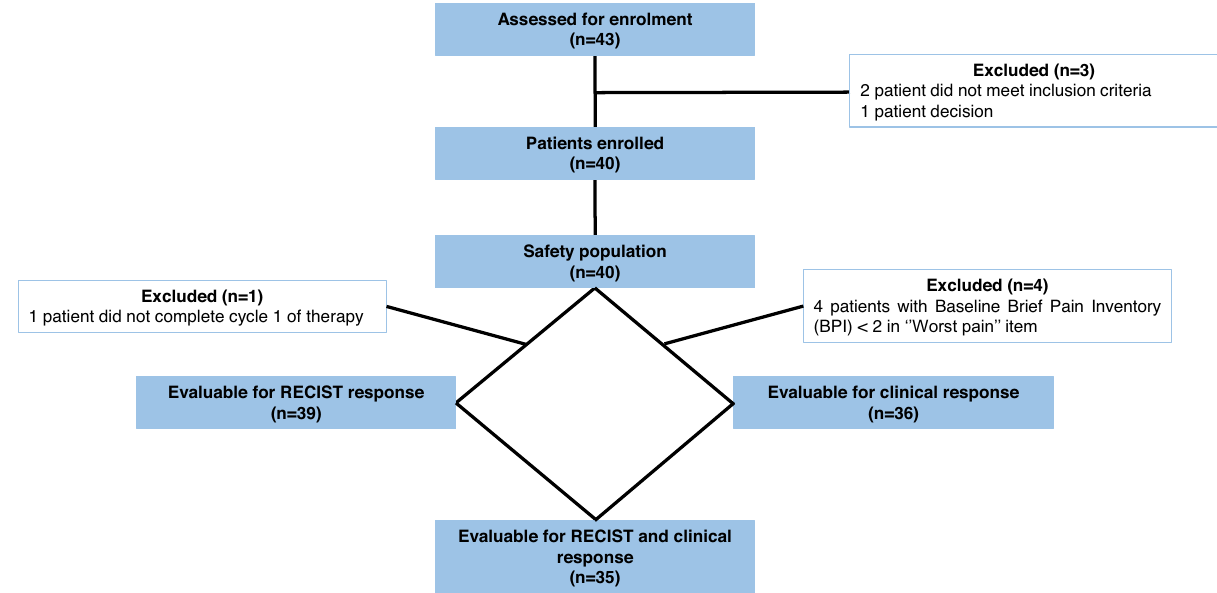
Fig. 1 | Consort diagram. This fi gure summarizes the fl ux of patients in the